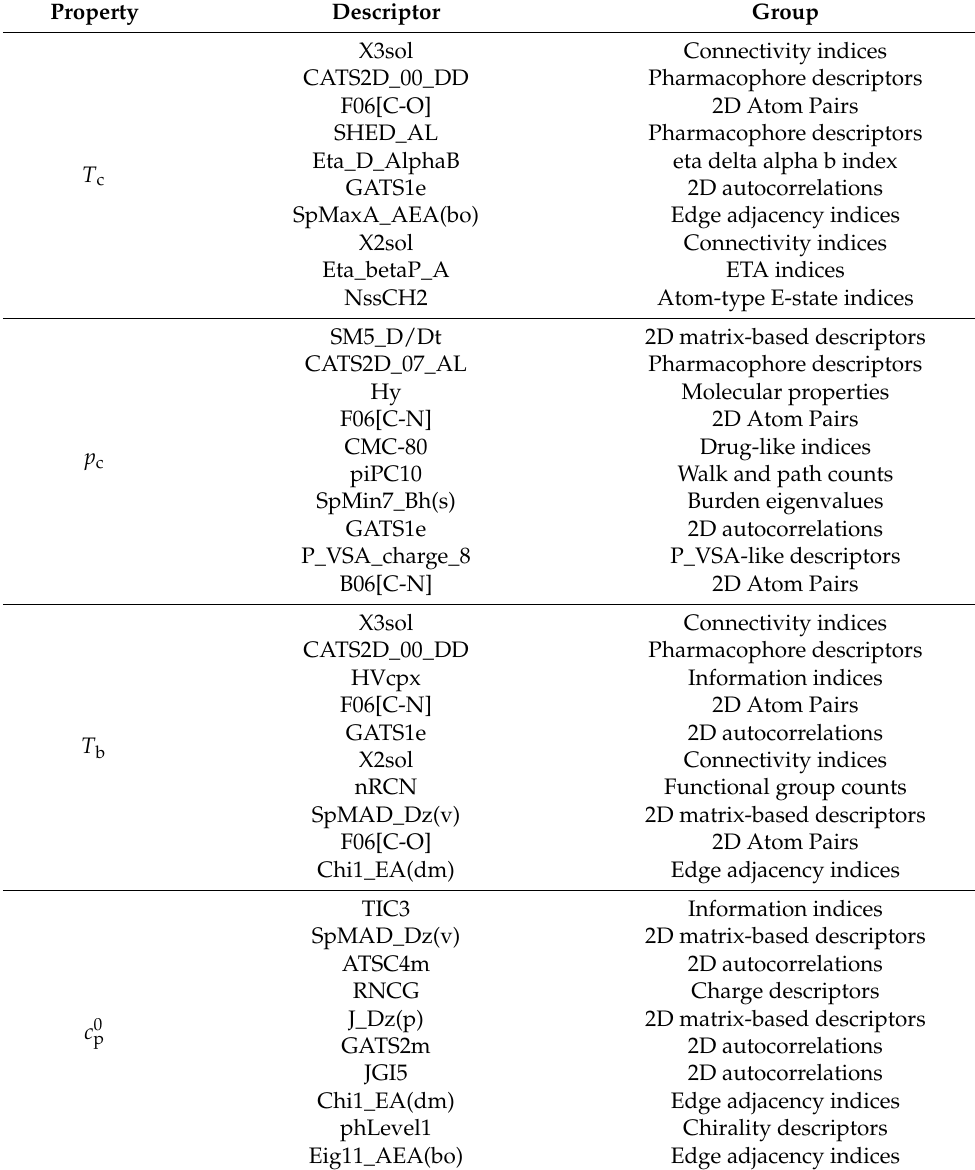
Table 1. Molecular descriptors of T c , T b , p c, and c 0 p QSPR